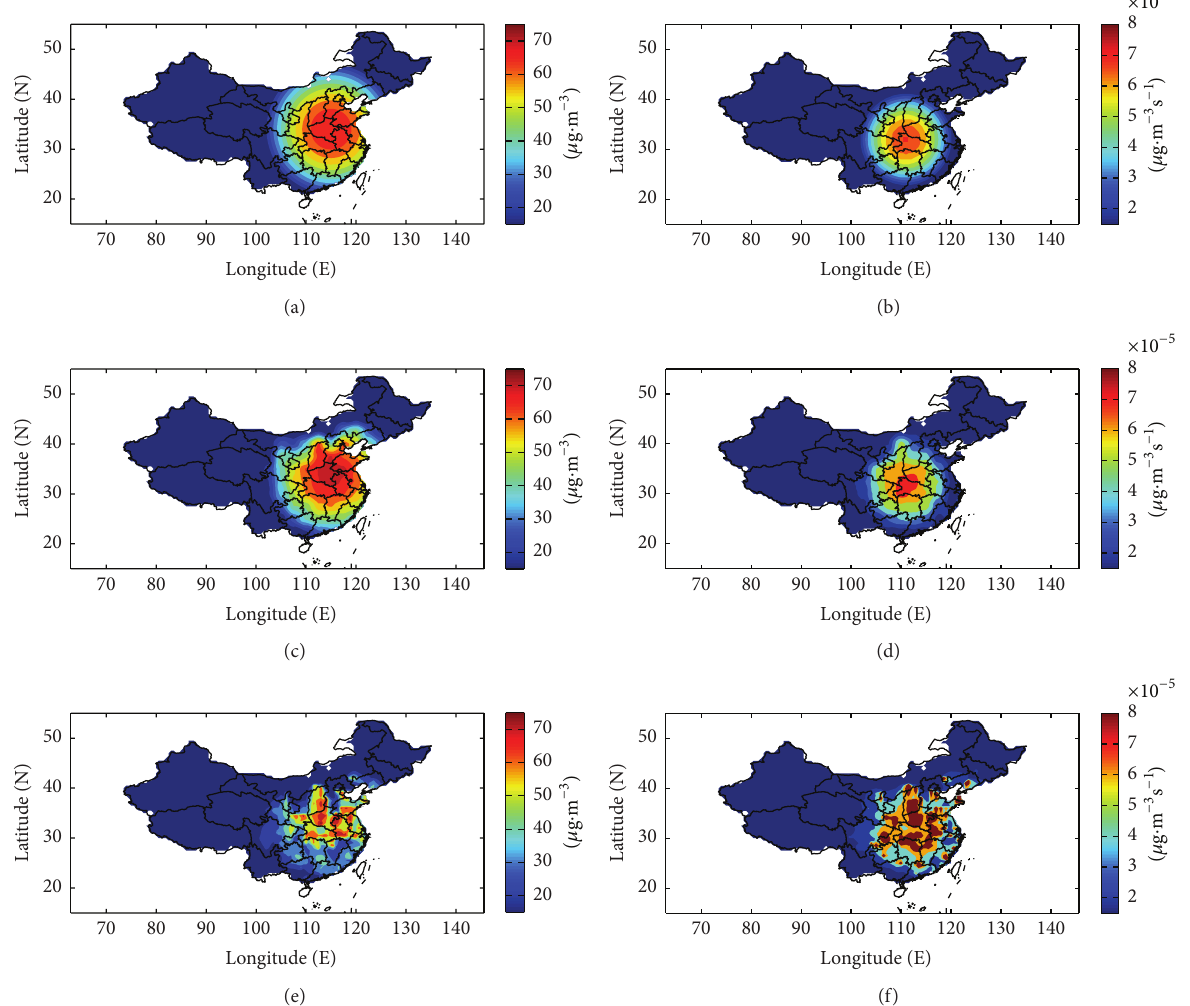
Figure 3: (a) The prescribed IC which is the same as that in Figure 2(a), (b) the prescribed SS which is the same as that in Figure 2(b), (c) the inverted IC in TE3, (d) the inverted SS in TE3, (e) the inverted IC in TE6, and (f) the inverted SS in TE6.